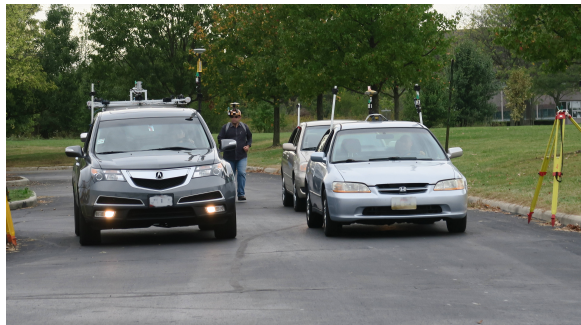
Figure 3. GPSVan track pattern during the experiment (gray), V2I TimeDomain static anchors (red circular marks), and main road area (red